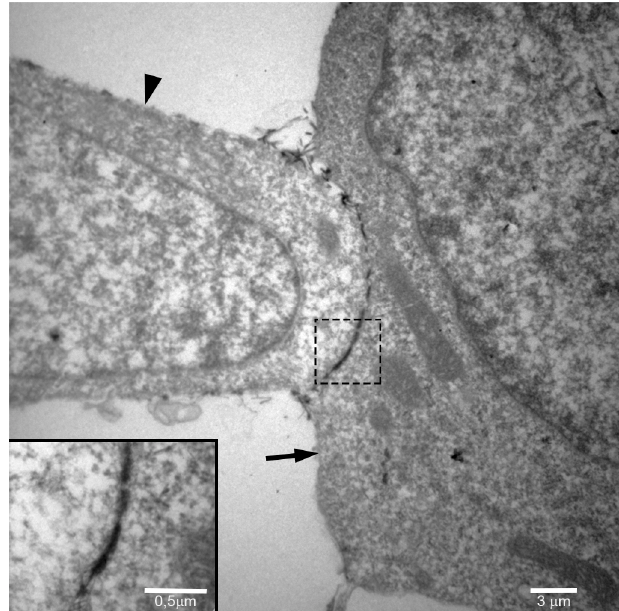
Figure 6. Gap junctions are present between mast cells and endothelial cells during in vitro angiogenesis. Transmission electron microscopy demonstrates that the space between the mast cell (arrow) and the endothelial cell (arrowhead) is filled with lanthanum, indicative of a gap junction. Inset: High magnification of the area delimited by dotted line.